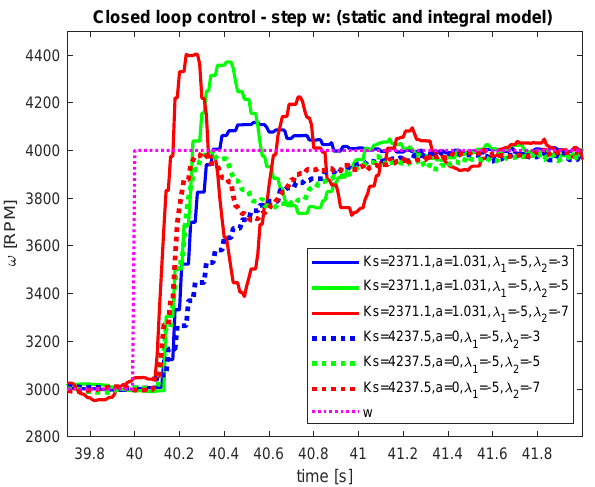
Figure 10. Comparison—setpoint step—process variable.